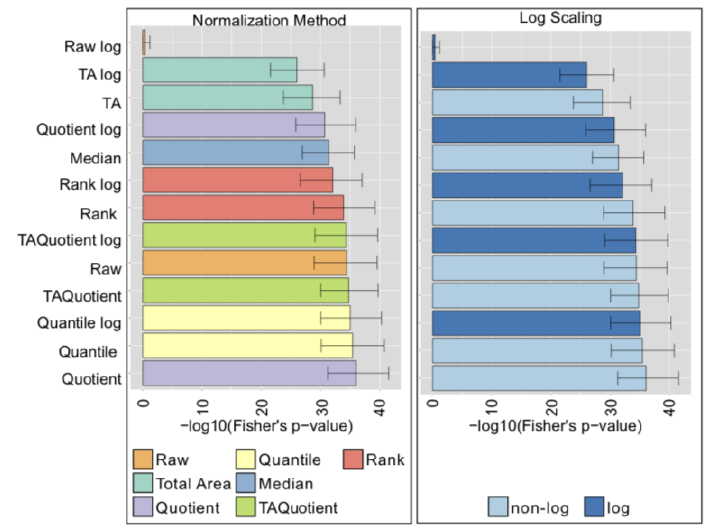
Figure 5. Matrix Assisted Laser Desorption Ionization-Furier Transform Ion Cyclotron Resonance (MALDI-FTICR-MS) normalization analysis results (Leiden Longevity Study cohort). Results in the panels are colored according to type of normalization (left), or log-transformation (right). Bars represent the median of the Fisher’s exact test p -values over 1000 bootstrapping, and error bars indicate the corresponding 95% confidence